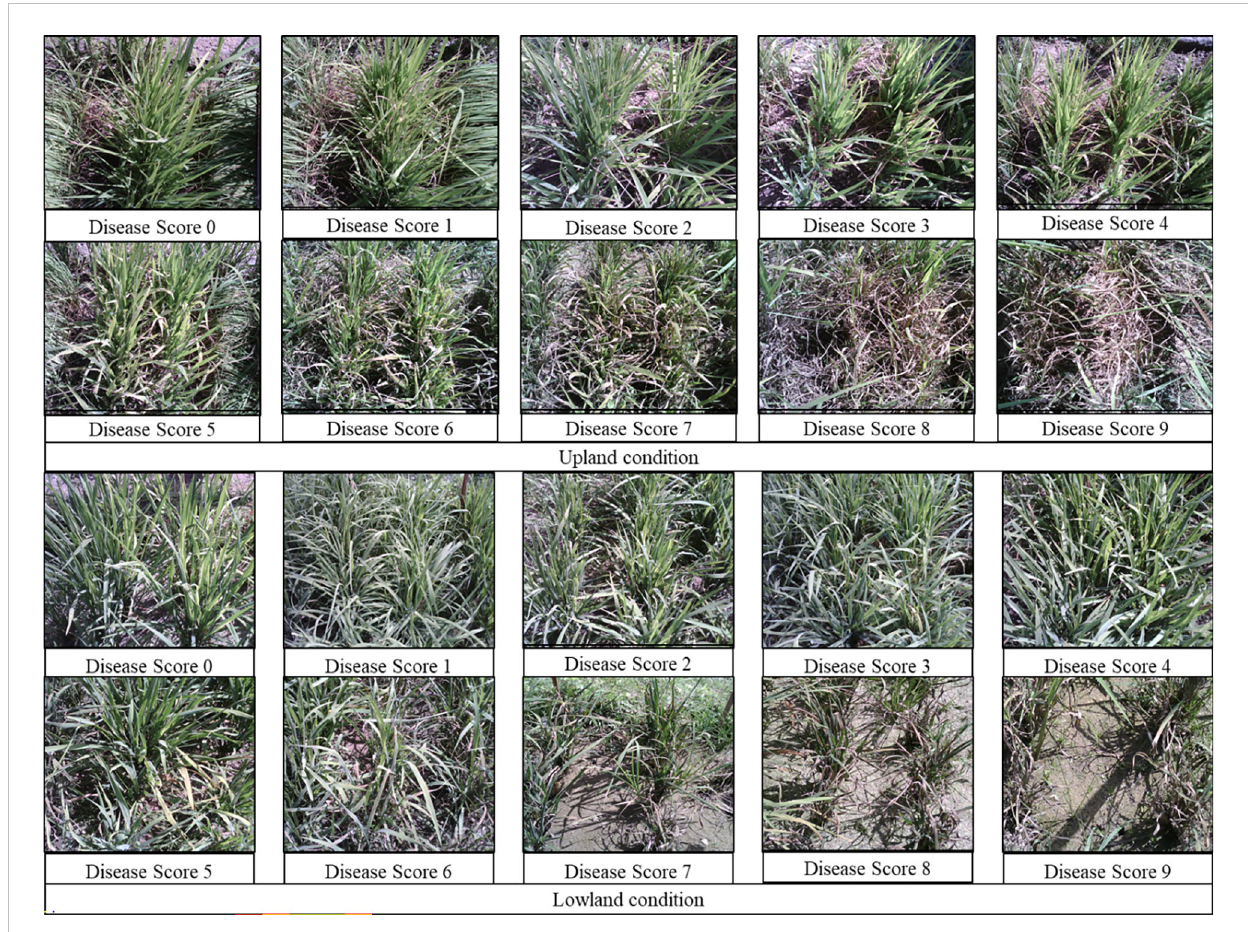
FIGURE 3 Different severity levels of rice blast infestation under upland and lowland